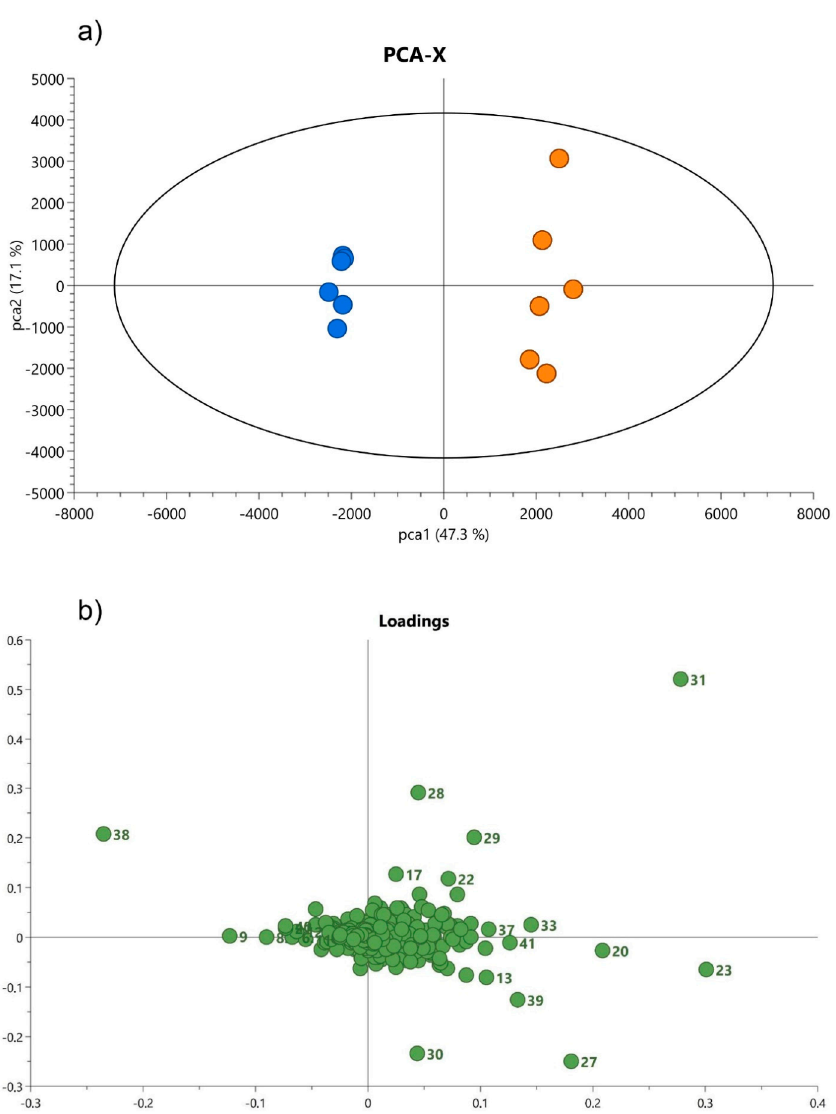
Figure 3. Principal component analysis presenting the relationship between the chemical profile of the main compounds in the leaf and species annotation of the analyzed plants; S. yangii (blue) and S. abrotanoides (orange) ( a ), with corresponding loadings (PCA model: R 2 X Cum = 0.767, Q 2 Cum = 0.45) ( b ). Each loading number corresponds to the peak number identified in the BPC